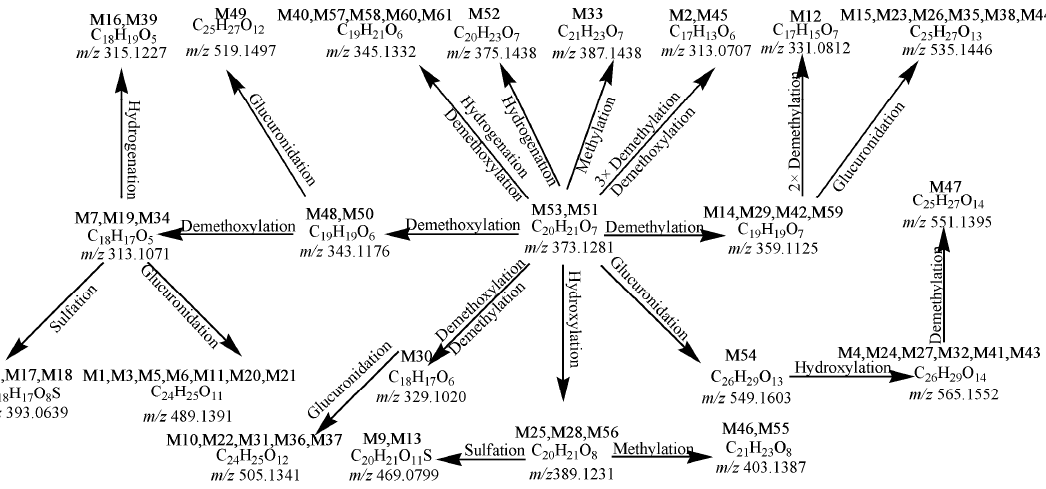
Figure 1. The proposed major metabolic pathway of PTC in the rat urine and feces.